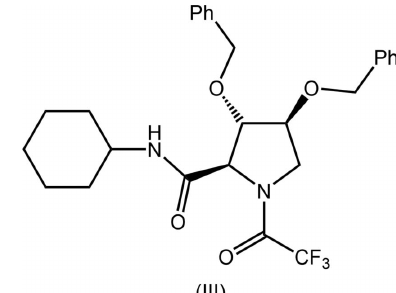
Figure 8 Chemical diagram for